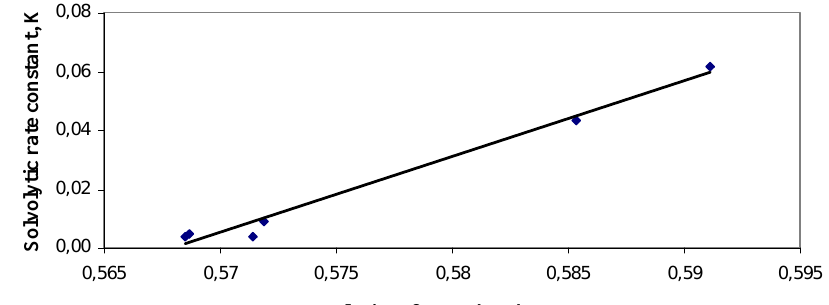
Figure 2. Correlation between polarity of C-O2 bond (B3LYP/STO-3G SCRF(COSMO, ethanol)) and solvolytic rate